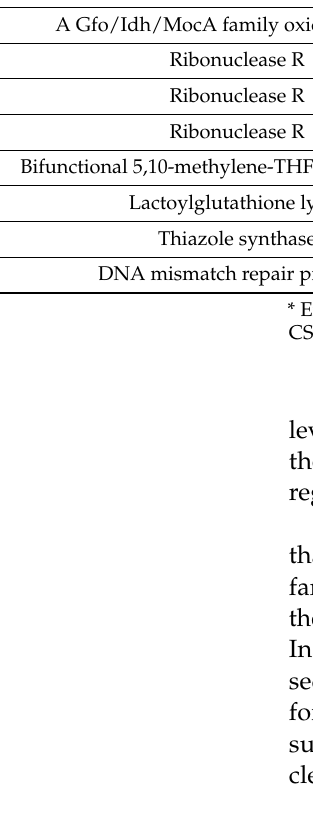
Table 2. Conserved Signature Indels Specific for Members of the families Chlorobiaceae and Chloroherpetonaceae * ,a